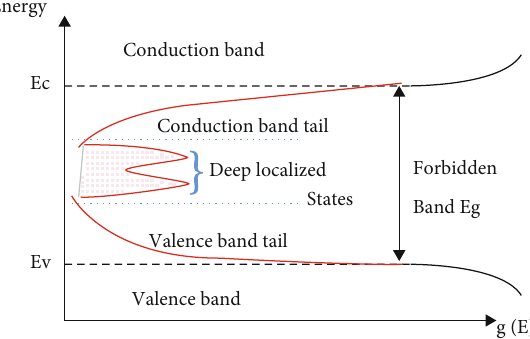
Figure 4: Band structure of amorphous